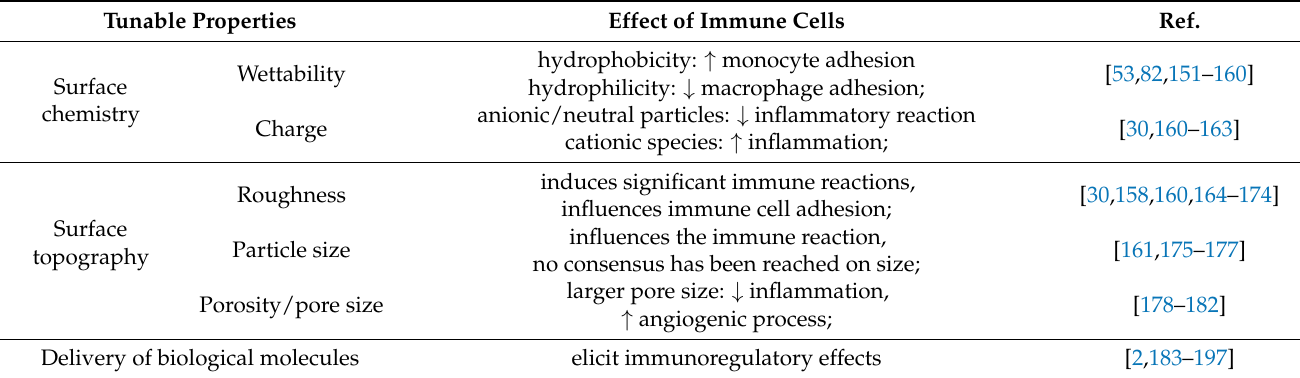
Table 1. Surface properties that influence the immune responses towards an implantable biomaterial. Tunable Properties Effect of Immune Cells